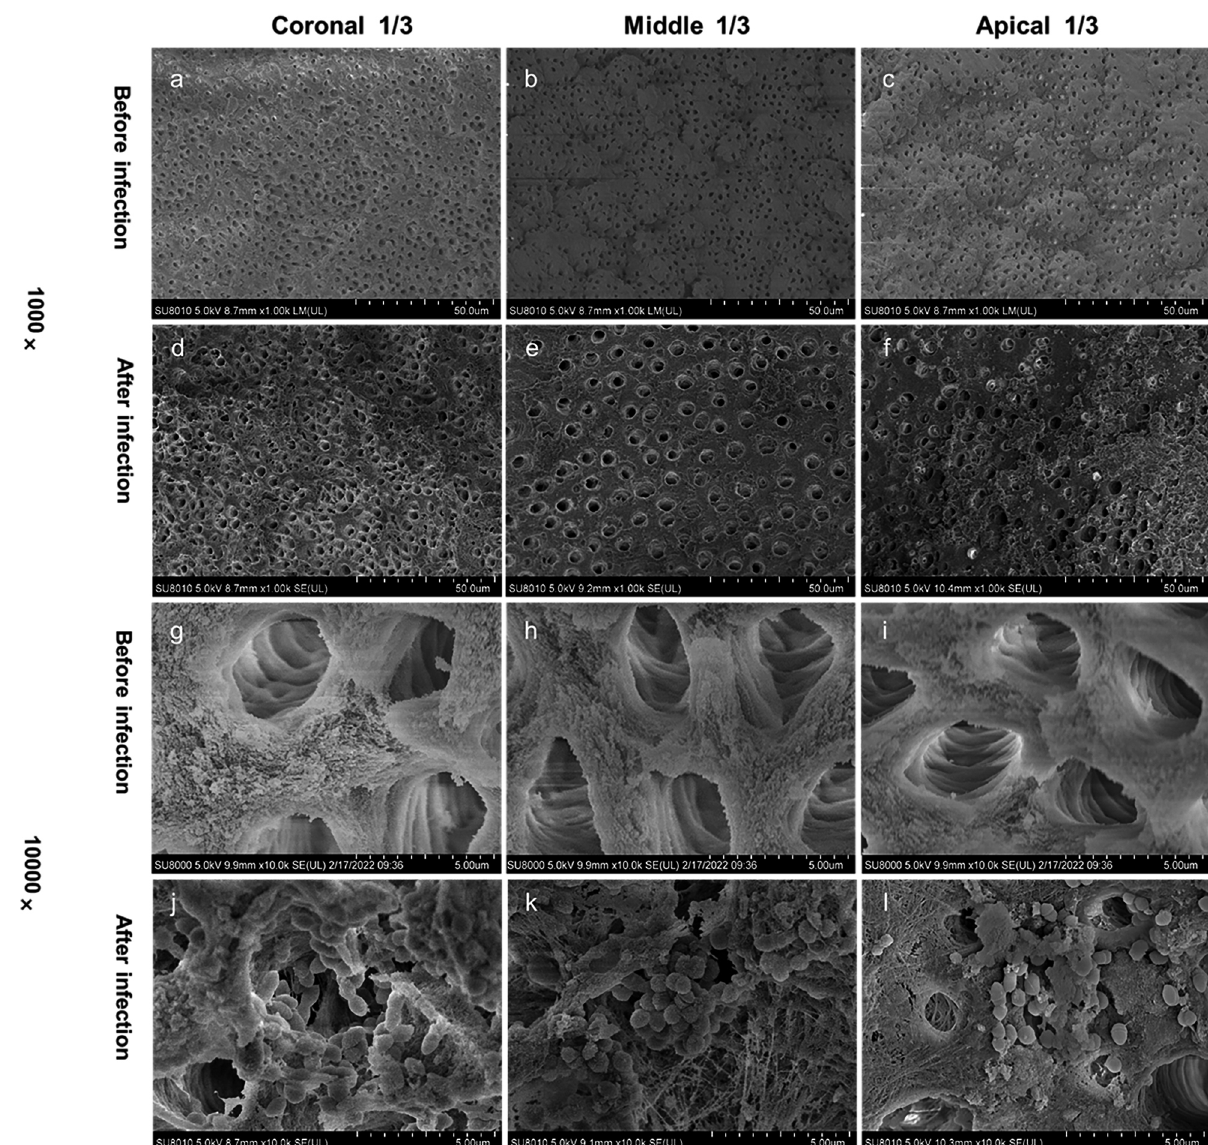
Figure 1- Scanning electron microscopy of the root canal wall before and after infection with Enterococcus faecalis (×1,000 and ×10,000); (a–c) the wall before infection under ×1,000 magnification; (d–f) the wall after infection under ×1,000 magnification; (g–i) open dentinal tubules without bacteria before infection under ×10,000 magnification; and (j–l) open dentinal tubules with bacteria growing after infection under ×10,000